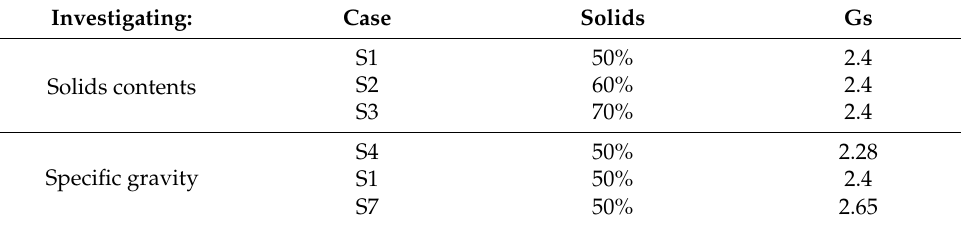
Table 3. Summary of the scenarios considered in the quasi-3D